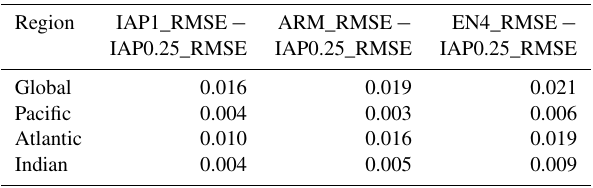
Table 2. RMSE of 1–2000m mean salinity for the IAP1 ◦ , AR- MOR3D, EN4, and IAP0.25 ◦ datasets (unit: